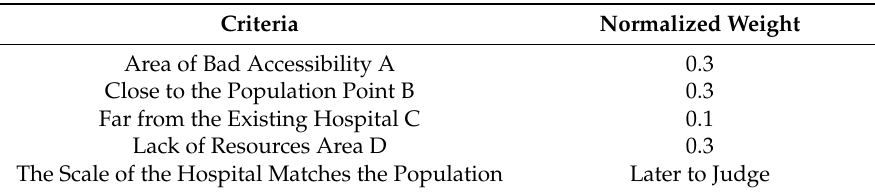
Table 7. Criteria and normalized weight allocation of location selection.